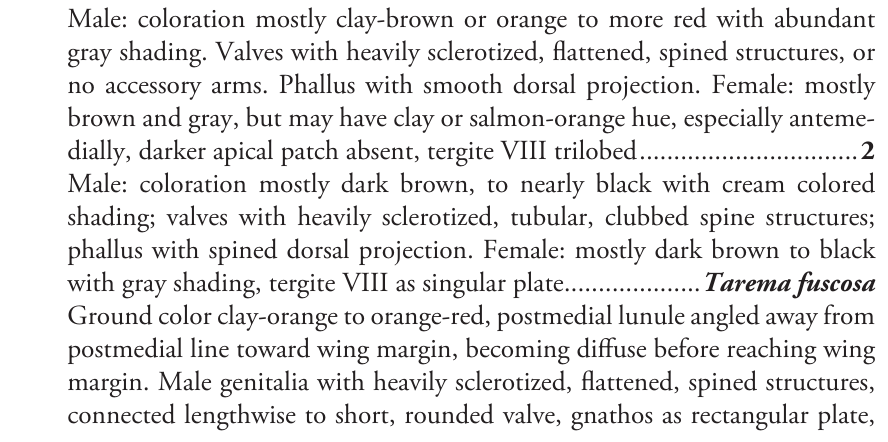
Male: coloration mostly clay-brown or orange to more red with abundant gray shading. Valves with heavily sclerotized, flattened, spined structures, or no accessory arms. Phallus with smooth dorsal projection. Female: mostly brown and gray, but may have clay or salmon-orange hue, especially anteme- dially, darker apical patch absent, tergite VIII trilobed ................................ 2 Male: coloration mostly dark brown, to nearly black with cream colored shading; valves with heavily sclerotized, tubular, clubbed spine structures; phallus with spined dorsal projection. Female: mostly dark brown to black with gray shading, tergite VIII as singular plate .................... Tarema fuscosa Ground color clay-orange to orange-red, postmedial lunule angled away from postmedial line toward wing margin, becoming diffuse before reaching wing margin. Male genitalia with heavily sclerotized, flattened, spined structures, connected lengthwise to short, rounded valve, gnathos as rectangular